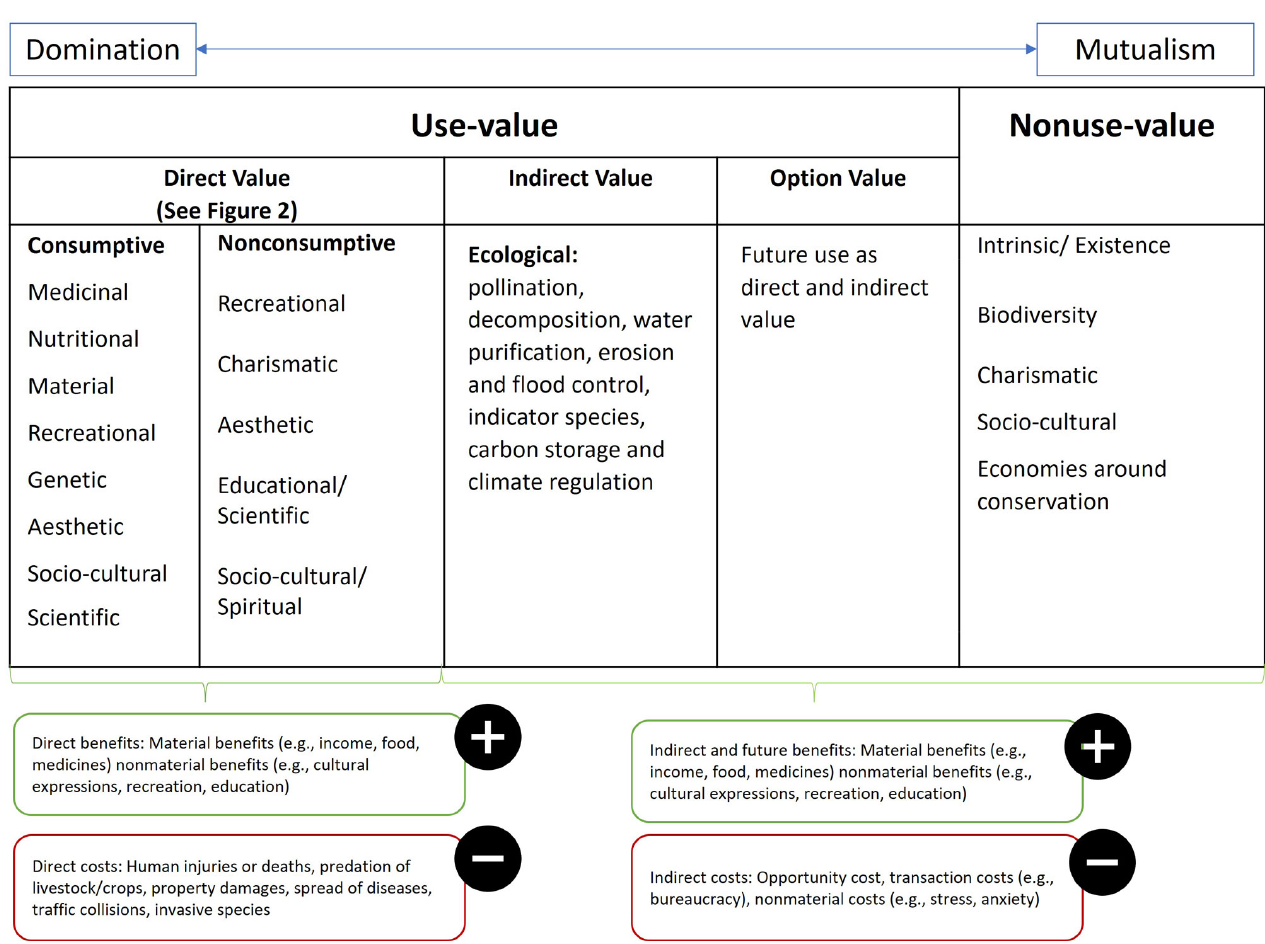
Fig. 1 . The wildlife value